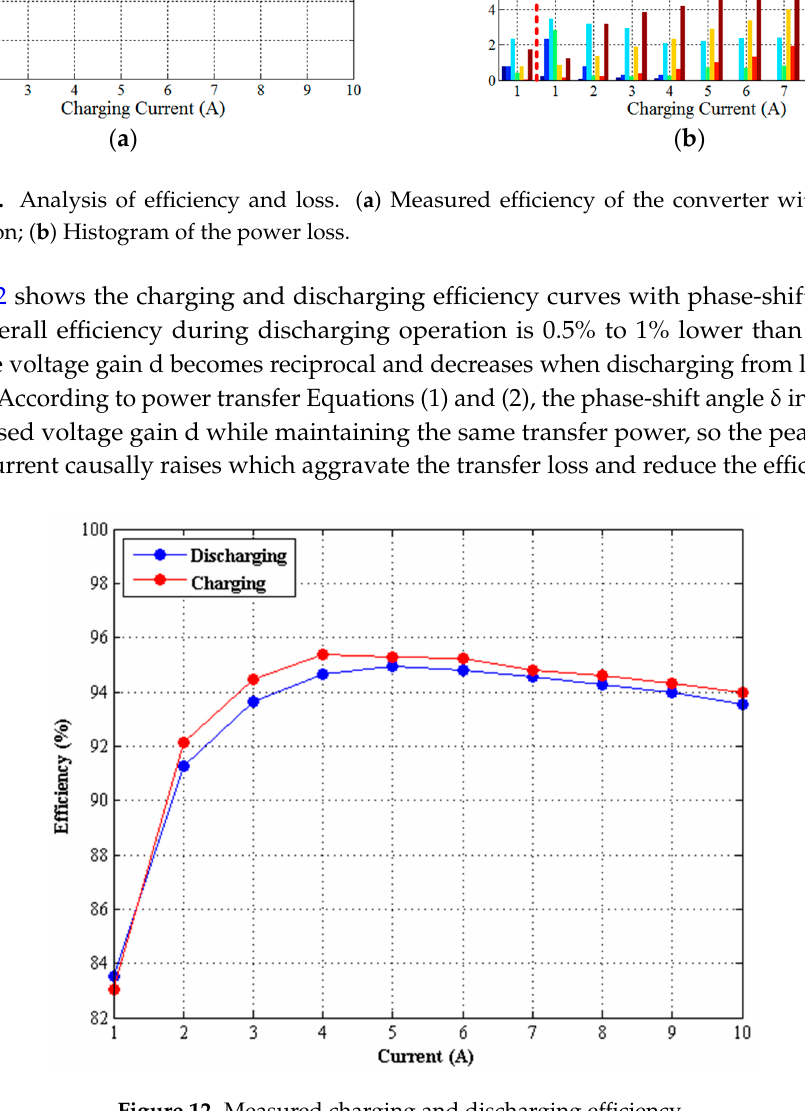
Figure 12. Measured charging and discharging efficiency.